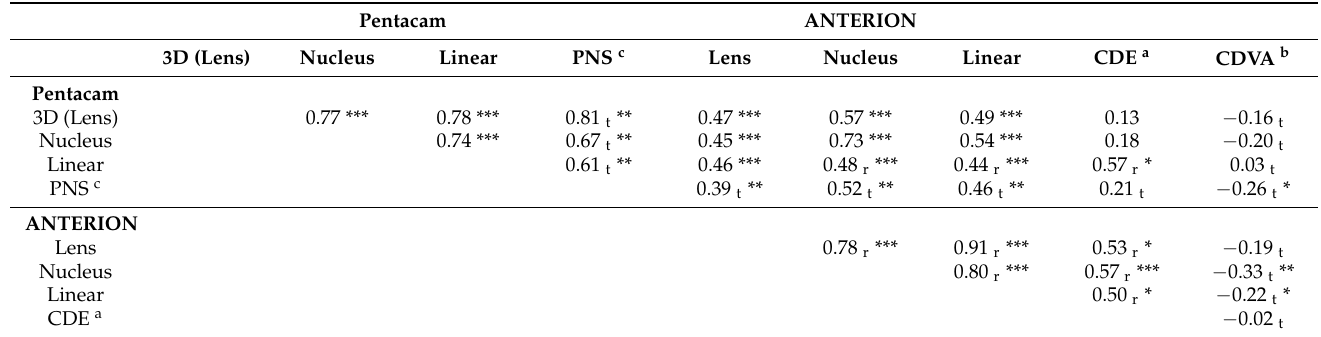
Table 2. Spearman, Pearson ( r ) or Kendall’s tau-b ( t ) correlations of lens density measurements, cumulative dissipated energy and corrected distance visual acuity. Only the correlation with CDE values without femtosecond laser use are